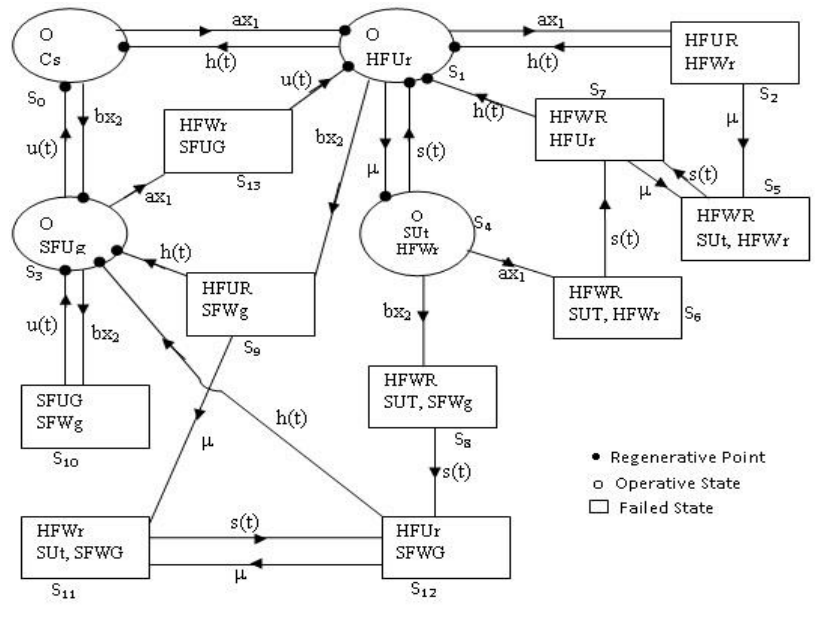
Figure 1. State transition